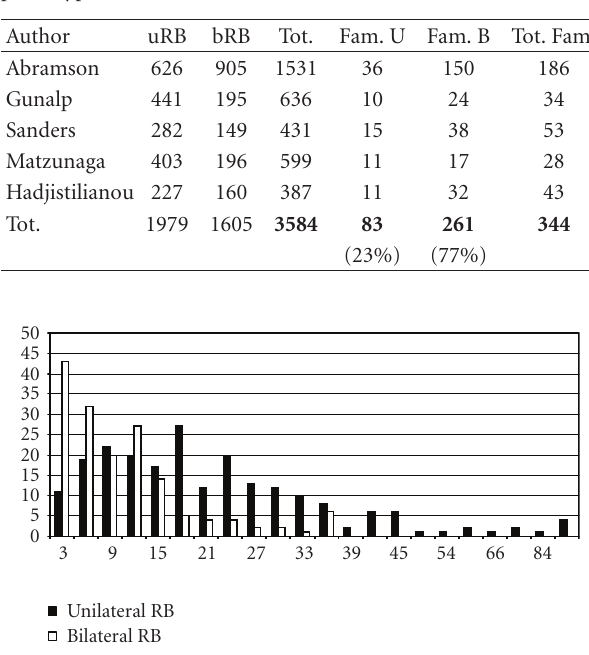
Figure 1: The distribution of retinoblastoma by laterality in a sample of 387 patients referred to the Ocular Oncology Unit of the Department of Ophthalmology of the University of Siena (Italy). Five cases, diagnosed beyond the age of 87 months, are not reported in the diagram. As it can be appreciated, the distribution of unilateral Rb by age at diagnosis is highly skewed, and therefore, the calculation of the “mean” in this sample may lead to unreliable inferences.